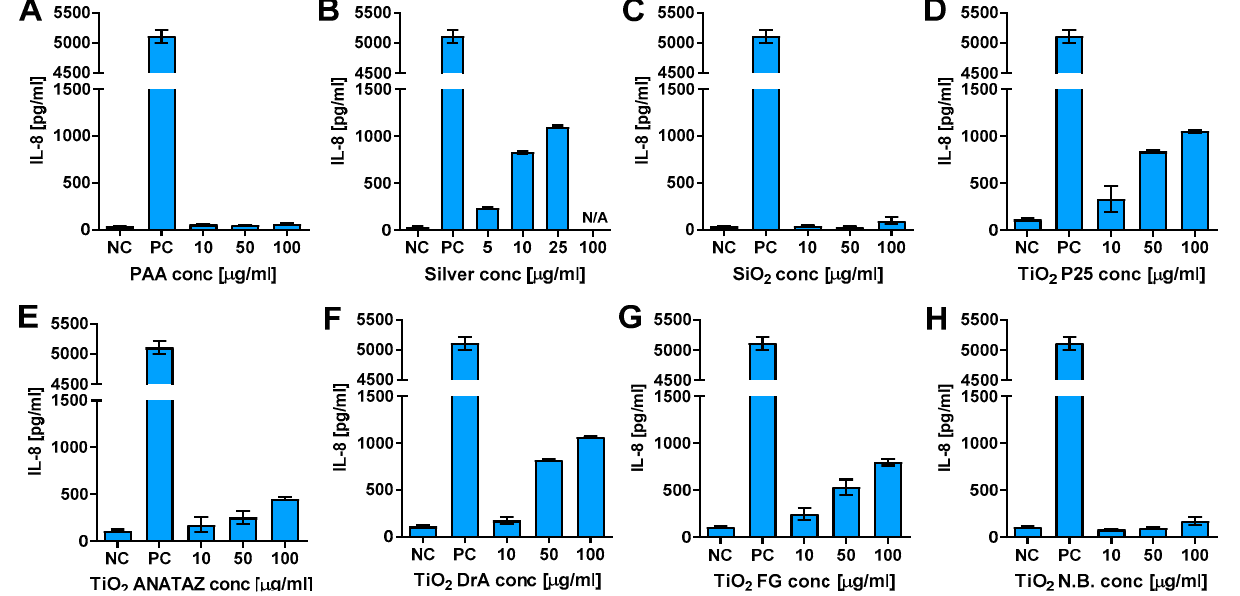
Figure 7. IL-8 secretion from THP-1 macrophages following 24 h incubation with increasing con- centrations of ( A ) polyacrylic acid (PAA)-coated NPs, ( B ) silver NPs, ( C ) engineered SiO 2 NPs, ( D ) TiO 2 P25, ( E ) TiO 2 ANATAZ NPs, ( F ) TiO 2 DrA NPs, ( G ) TiO 2 food-grade (FG), and ( H ) TiO 2 N.B. NPs, as determined using ELISA. Cell exposed to 100 ng mL − 1 LPS for 24 h were used as a positive control. Please note, that lower concentrations were used for silver NPs due to extensive cells death. Representative experiment of the three experiments is shown. Mean and standard error of three replicates of the same biological repeat are shown.